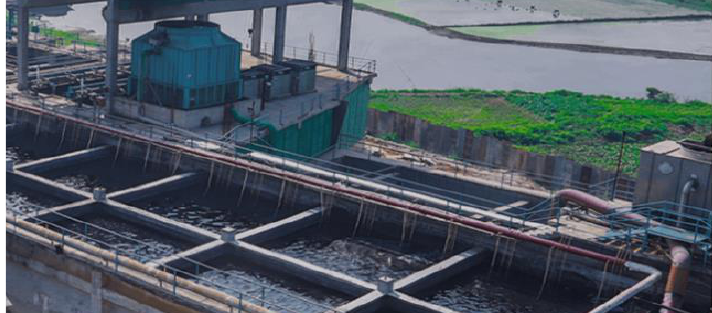
Figure 1: ETP Plant with MBR technology used in Tamishna group at Tongi, Dhaka,